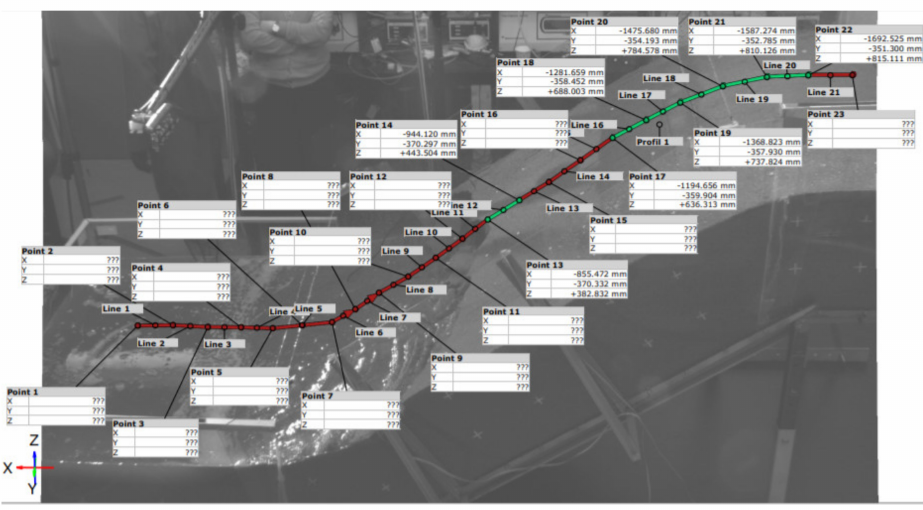
Figure 10. 3D view of the analyzed stages of the longitudinal profile—Stage 330 [66].